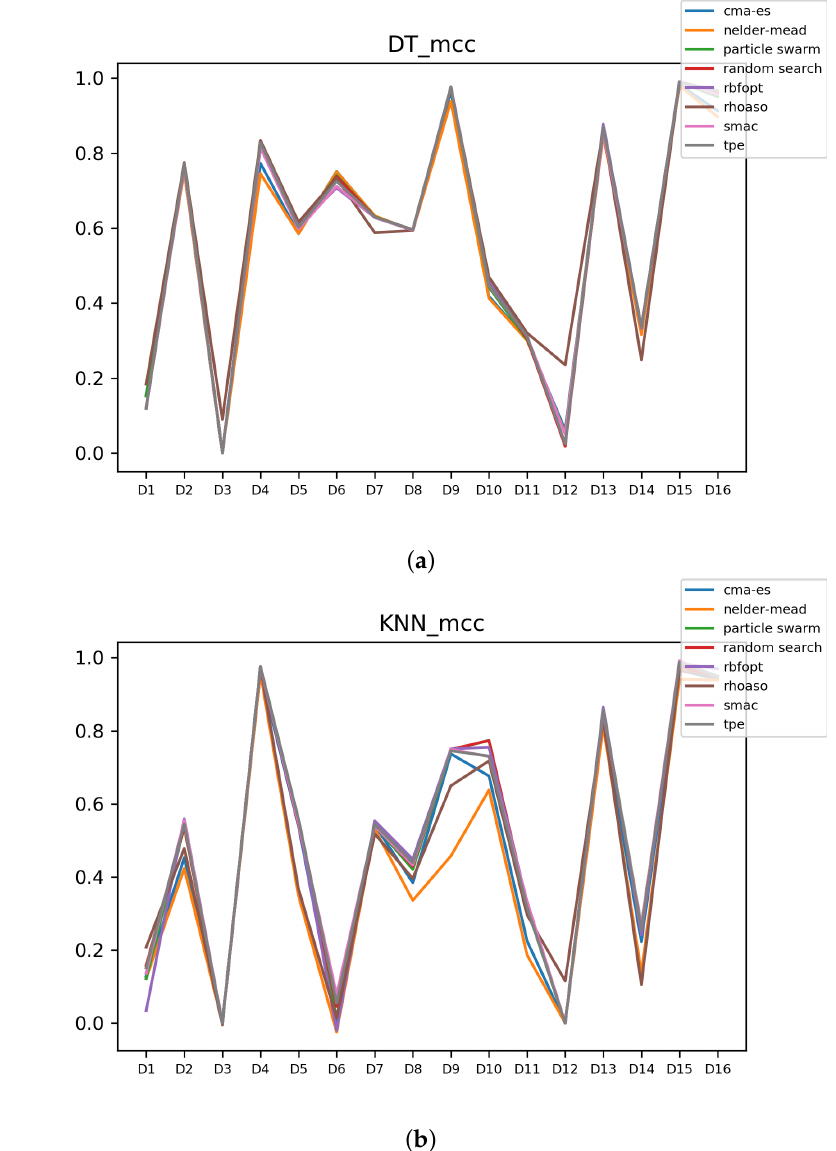
Figure A9. MCC of all HPO algorithms. ( a ) MCC in DT. ( b ) MCC in KNN.